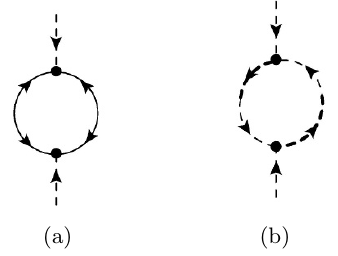
Figure 7 . One-loop corrections for the h (cid:30)(cid:30) i correlation